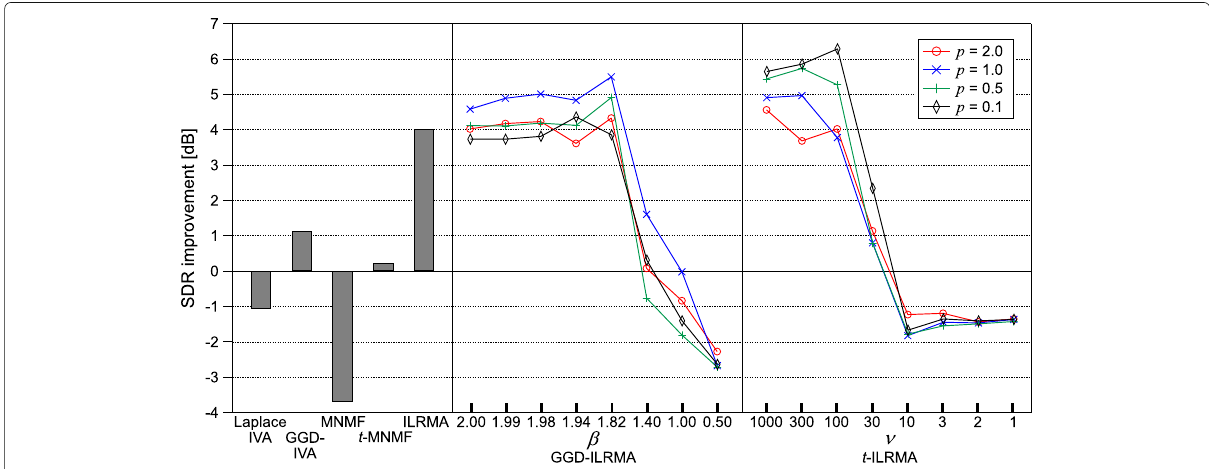
Fig. 14 Average SDR improvements of Speech 3 with E2A_2 signal using fixed parameters. The results for GGD-IVA and t -MNMF using β = 0.5 and ν = 1 are shown, which are their best parameter